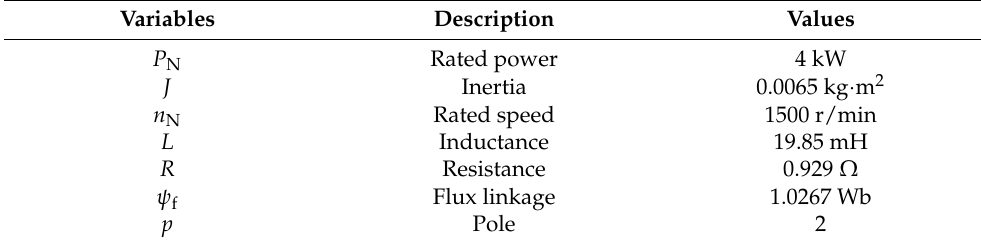
Table 2. Parameters of the SPMSM.